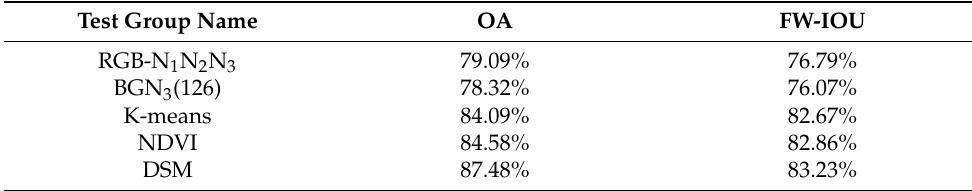
Table 9. Incorporation of texture, vegetation index, and DSM evaluation